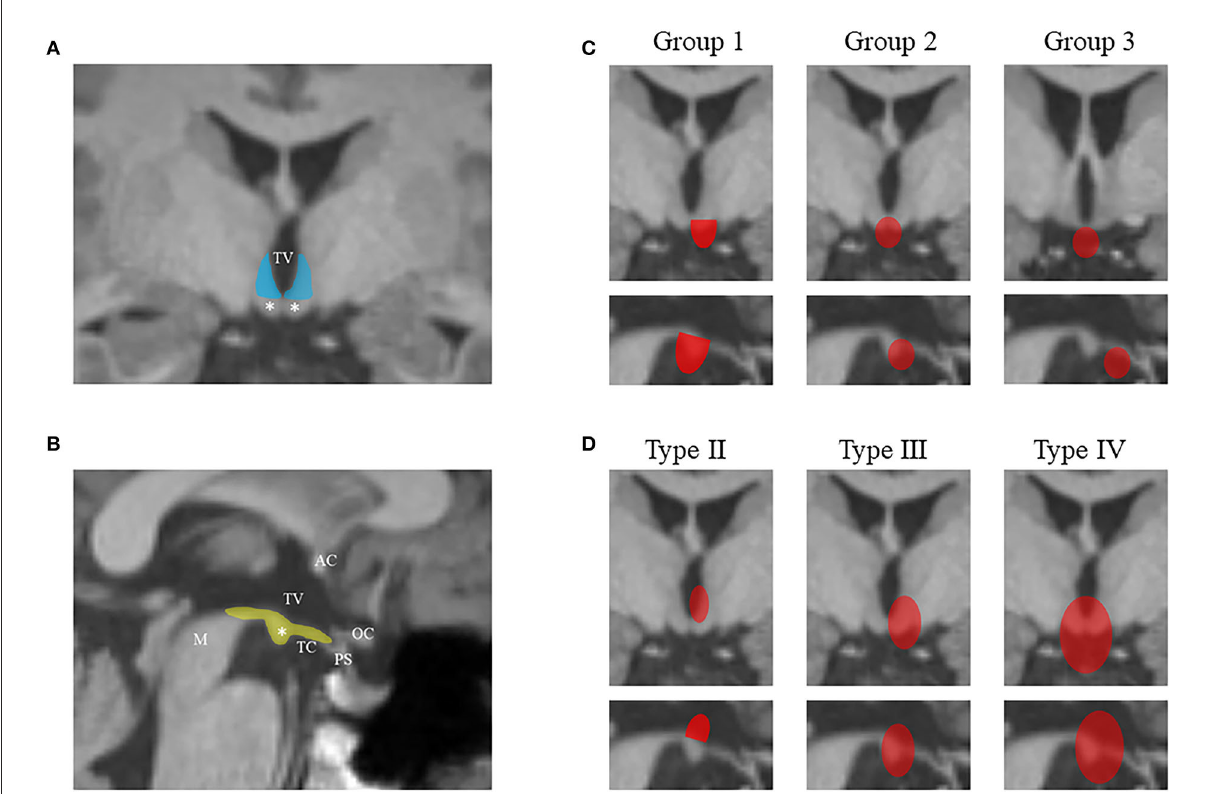
FIGURE1 The diagram shows the hypothalamus-related structures from the coronal scan (A) and sagittal scan (B) of MRI. The lateral hypothalamus from the vertical plane is colored in blue, and the structures on the horizontal plane are colored in yellow. The mammillary bodies are marked by white asterisks. The classification system in this study is illustrated in (C) and (D) using coronal and sagittal scans. HHs are colored in red. (C) The modified classification of Delalande Type I (lesions have a horizontal base of attachment below the normal position of the subventricular floor) based on the relationship between the lesion and MB: entire invasion (Group 1), partial connection (Group 2), and no connection (Group 3). (D) Other three types of Delalande classification. Type II lesions have a vertical plane of attachment to the wall of the third ventricle, completely above the subventricular floor. Type III lesions have a plane of attachment that extends both above and below the subventricular floor. Consequently, these lesions have both vertical and horizontal planes of attachment. Type IV lesions were termed “giant” with bilateral